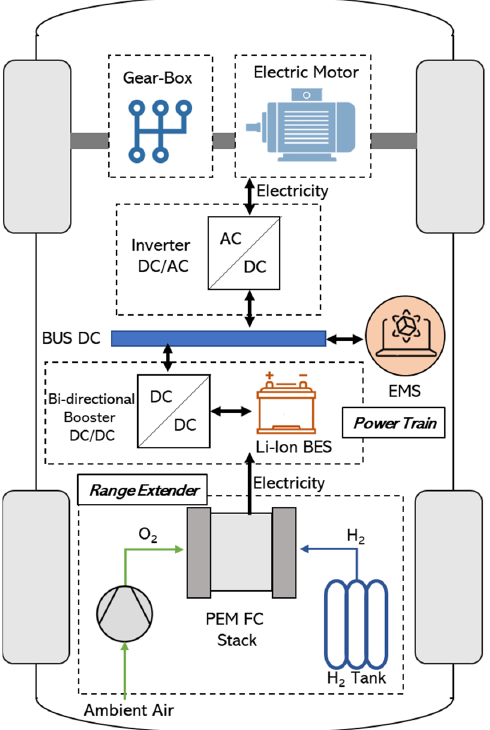
Figure 4. Fuel cell Range Extender Configuration for Electric Vehicles.